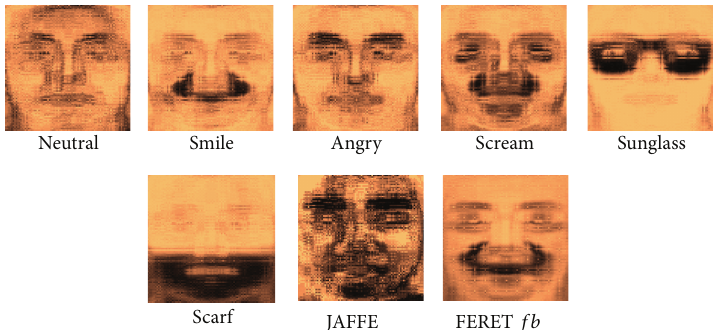
Figure 13: Result of learning by 𝜏 𝑠 prediction for several face datasets where each pixel in L location within the images represents the synaptic time constant 𝜏 𝑠 of synaptic connection between CD neuron and input neuron attached to the L location. Darker pixels represent higher 𝜏 𝑠 and vice versa. Number of epochs used is 1.